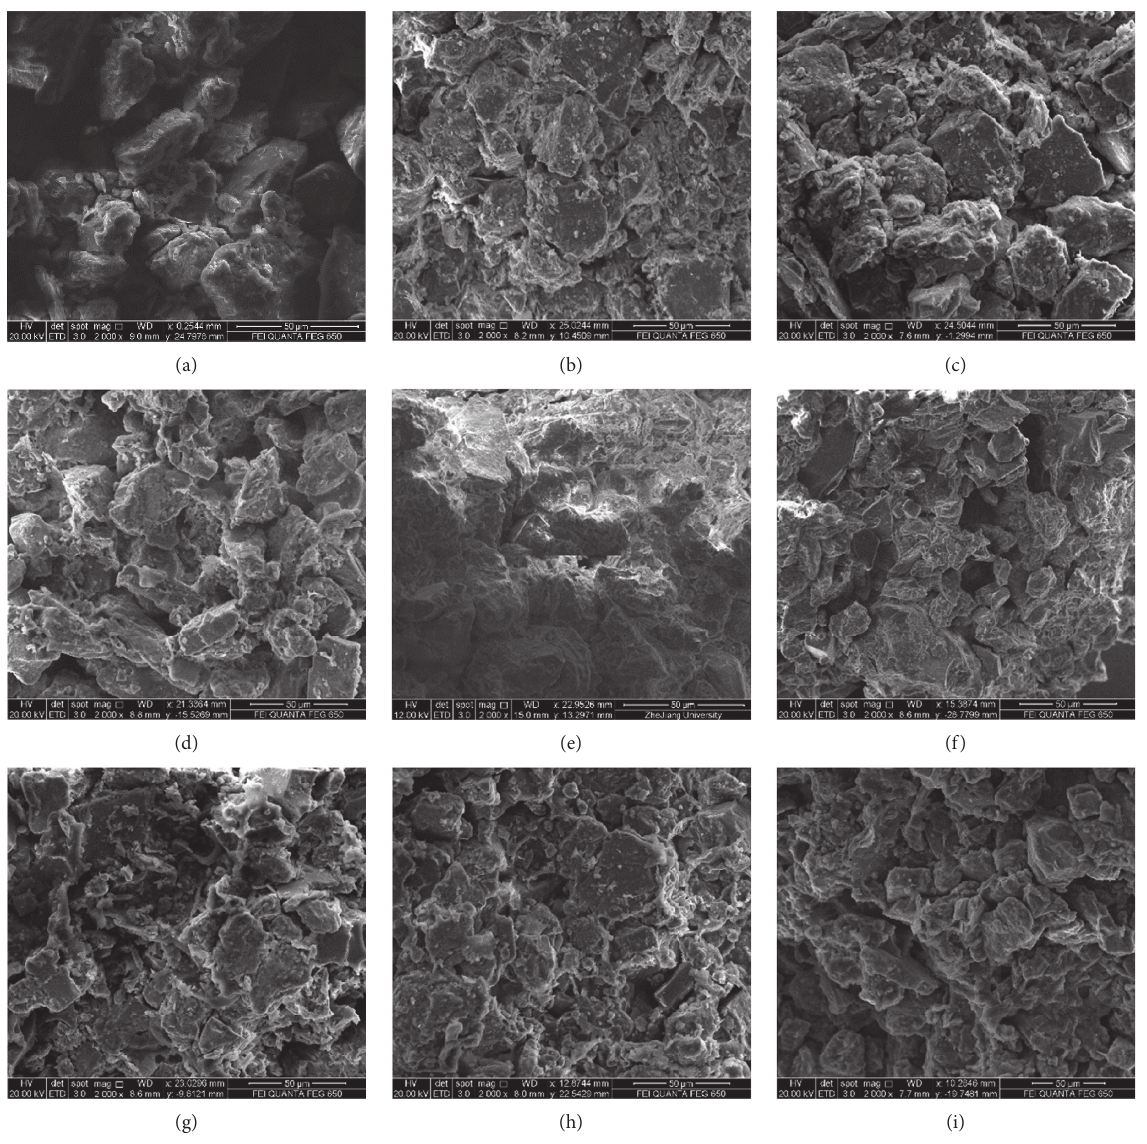
Figure 10: 2000 × SEM results of the specimens mixed in different mass ratios (120 days, 20 ° C, and 50% humidity). (a) T